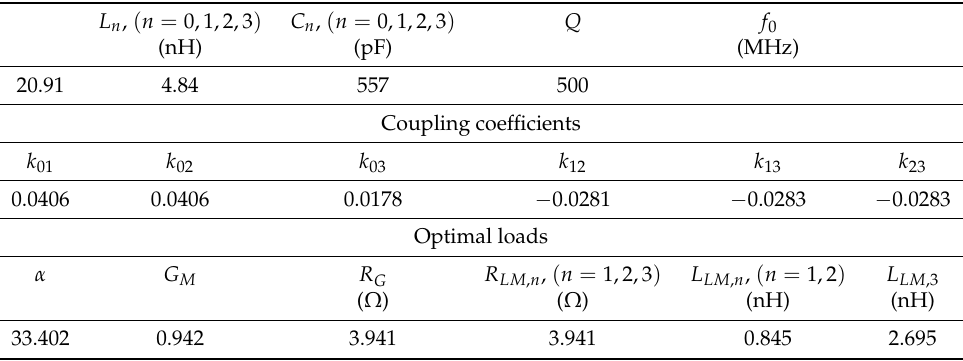
Table 2. Parameters of the equivalent circuit and optimal loads of the WPT link illustrated in Figure 5b (Case